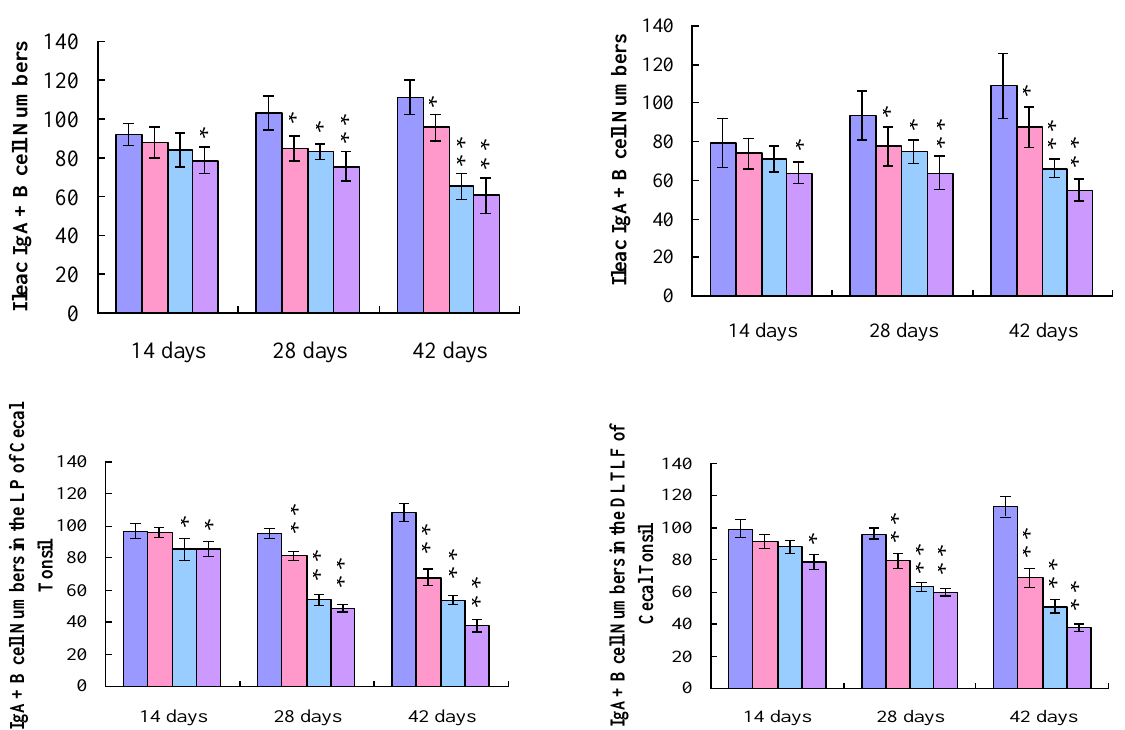
Figure 5. Change in the IgA + B cell number in the lamina propria (LP) of the ileum and the LP, the diffuse lymphoid tissues and lymphoid follicles (DLTLF) of the cecal